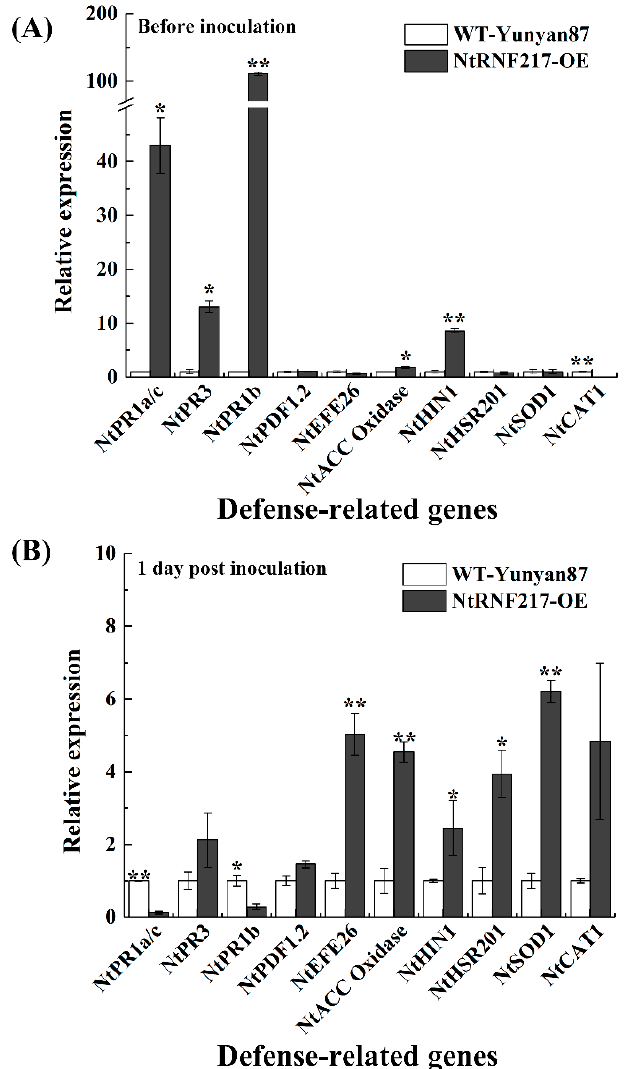
Figure 7. The relative gene expressions before and after inoculation with Ralstonia solanacearum . qRT-PCR was performed before ( A ) and 1 day post inoculation ( B ). Plants were inoculated with 10 mL of R. solanacearum cells (approximate 10 8 CFU mL − 1 ) by root irrigation. The NtUBI3 gene was used as a reference gene. The gene transcript levels in WT-Yunyan87 plants were converted to 1 and used as controls. Error bars indicate the standard error of three overexpression lines. Asterisks indicate a significant difference determined by t -test (* p < 0.05 or ** p < 0.01).